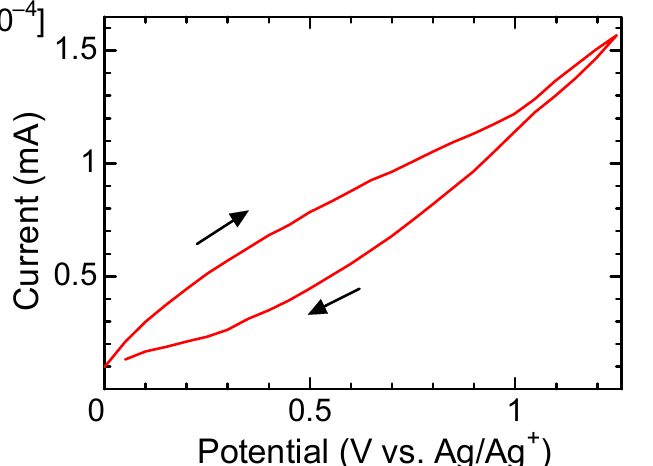
Figure 15. Electrochemical polymerization of bithiophene on V-CB(PANI) with the cyclic voltammetry method. Arrows indicate scanning directions.